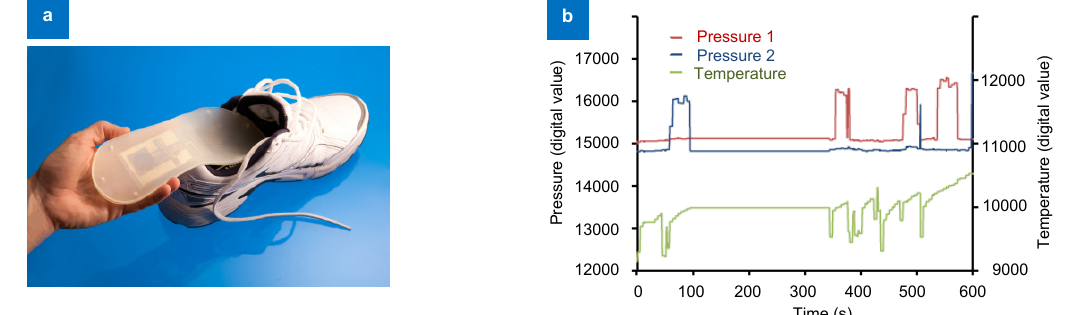
Fig. 4 | ( a ) Printed wireless pressure and temperature sensor within a shoe's insole. ( b ) Pressure and temperature data obtained through wireless communication from the printed insole 22